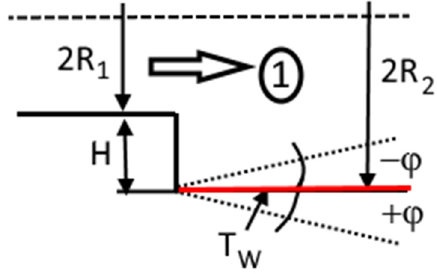
Figure 1. Schematic view of the flow in diffuser (APG, + ϕ ), confuser (FPG, − ϕ ), and in the separated flow in pipe sudden expansion (ZPG, ϕ = 0). 1 is the droplet-laden flow.